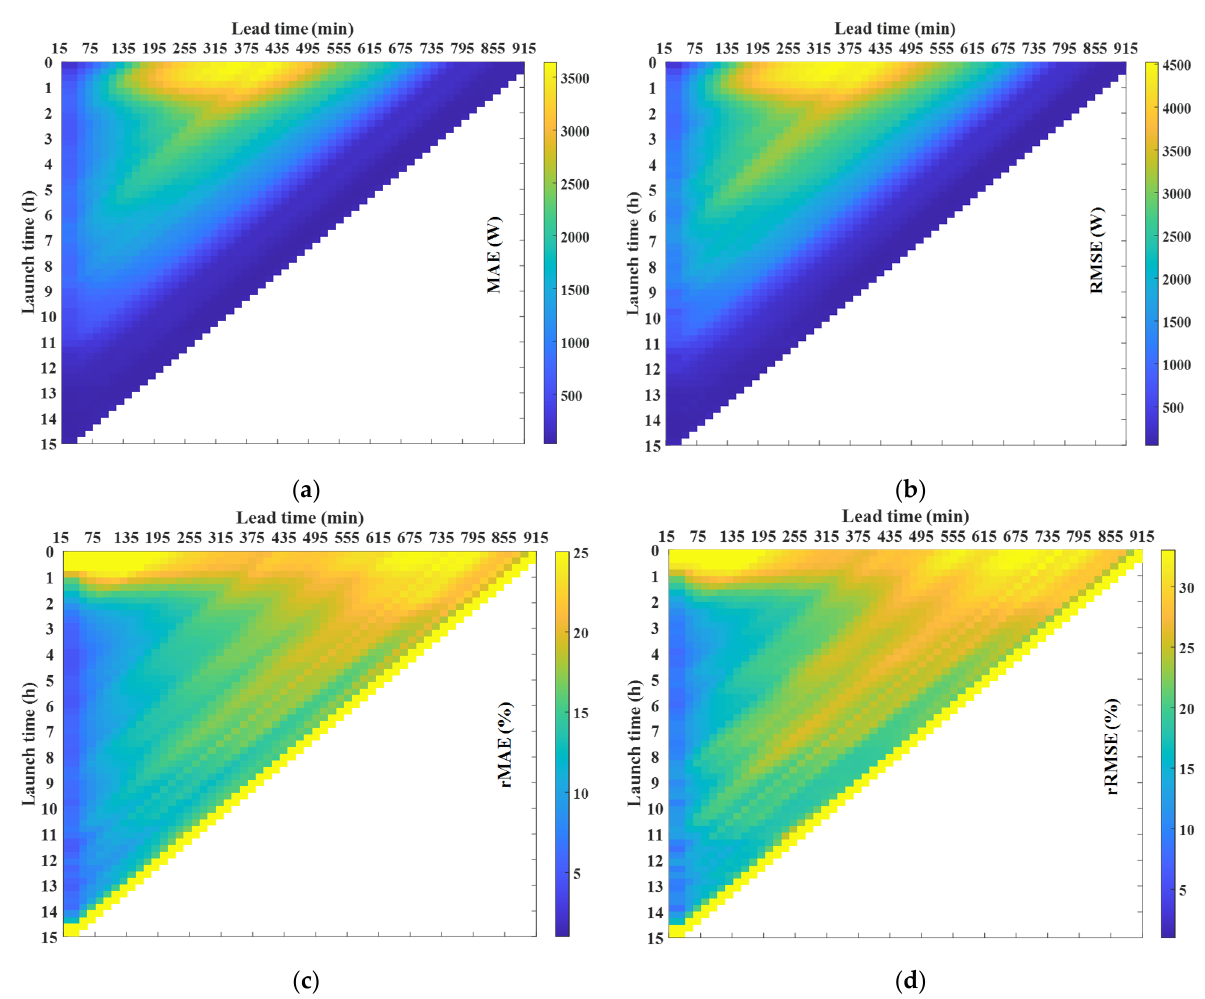
Figure 13. Error matrices of PV power forecasts from the VPP emulated in the research, represented as the sum of 8 different VPP nodes located in the Community of Madrid, as a function of the launch time and the lead time: ( a ) MAE ; ( b ) RMSE ; ( c ) rMAE ; and ( d ) rRMSE .